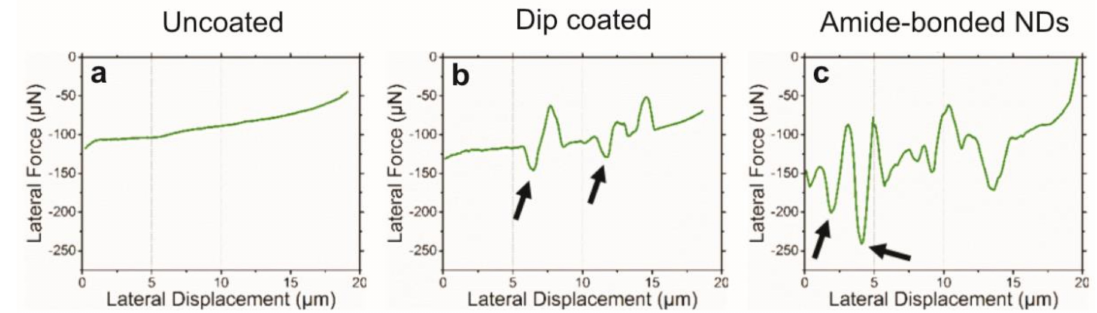
Figure 3. Representative nanoindentation tests of ( a ) uncoated, ( b ) dip-coated, and ( c ) amide-bonded NDs to Si. Graphs show the lateral force as a function of the lateral displacement of the indentation